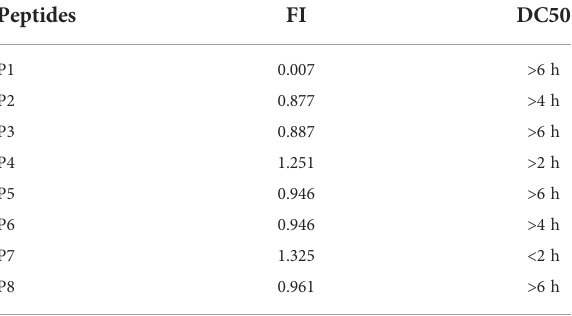
TABLE 2 The HLA-A*0201 binding af fi nity and stability of peptides.